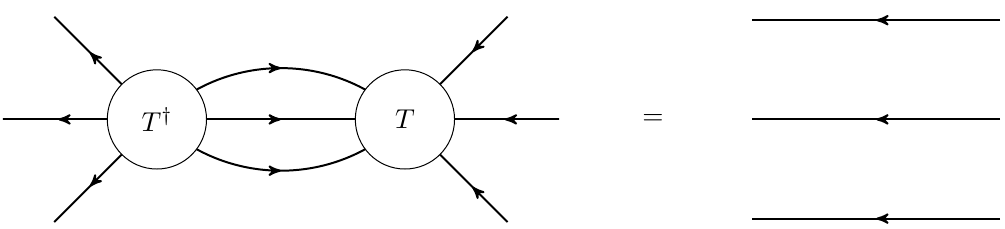
Figure 5. Illustration of the defining condition for perfect tensors. The same equality must hold when any subset consisting of half the legs is